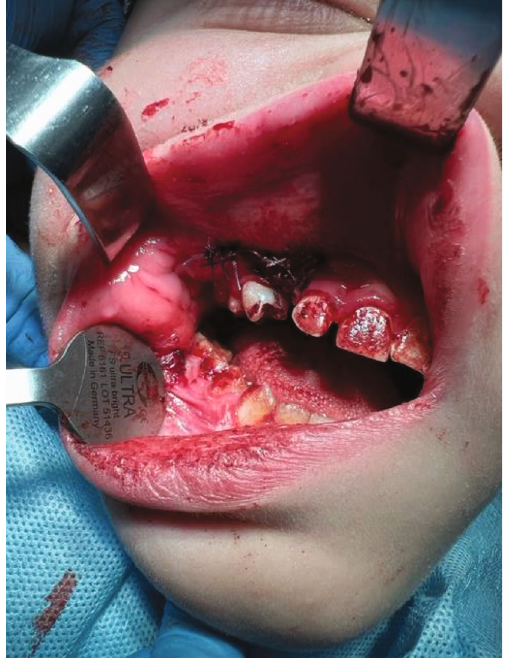
Figure 5: The wound closed with resorbable sutures. Depth of the vestibule is decreased due to the necessity of closing oroantral fi